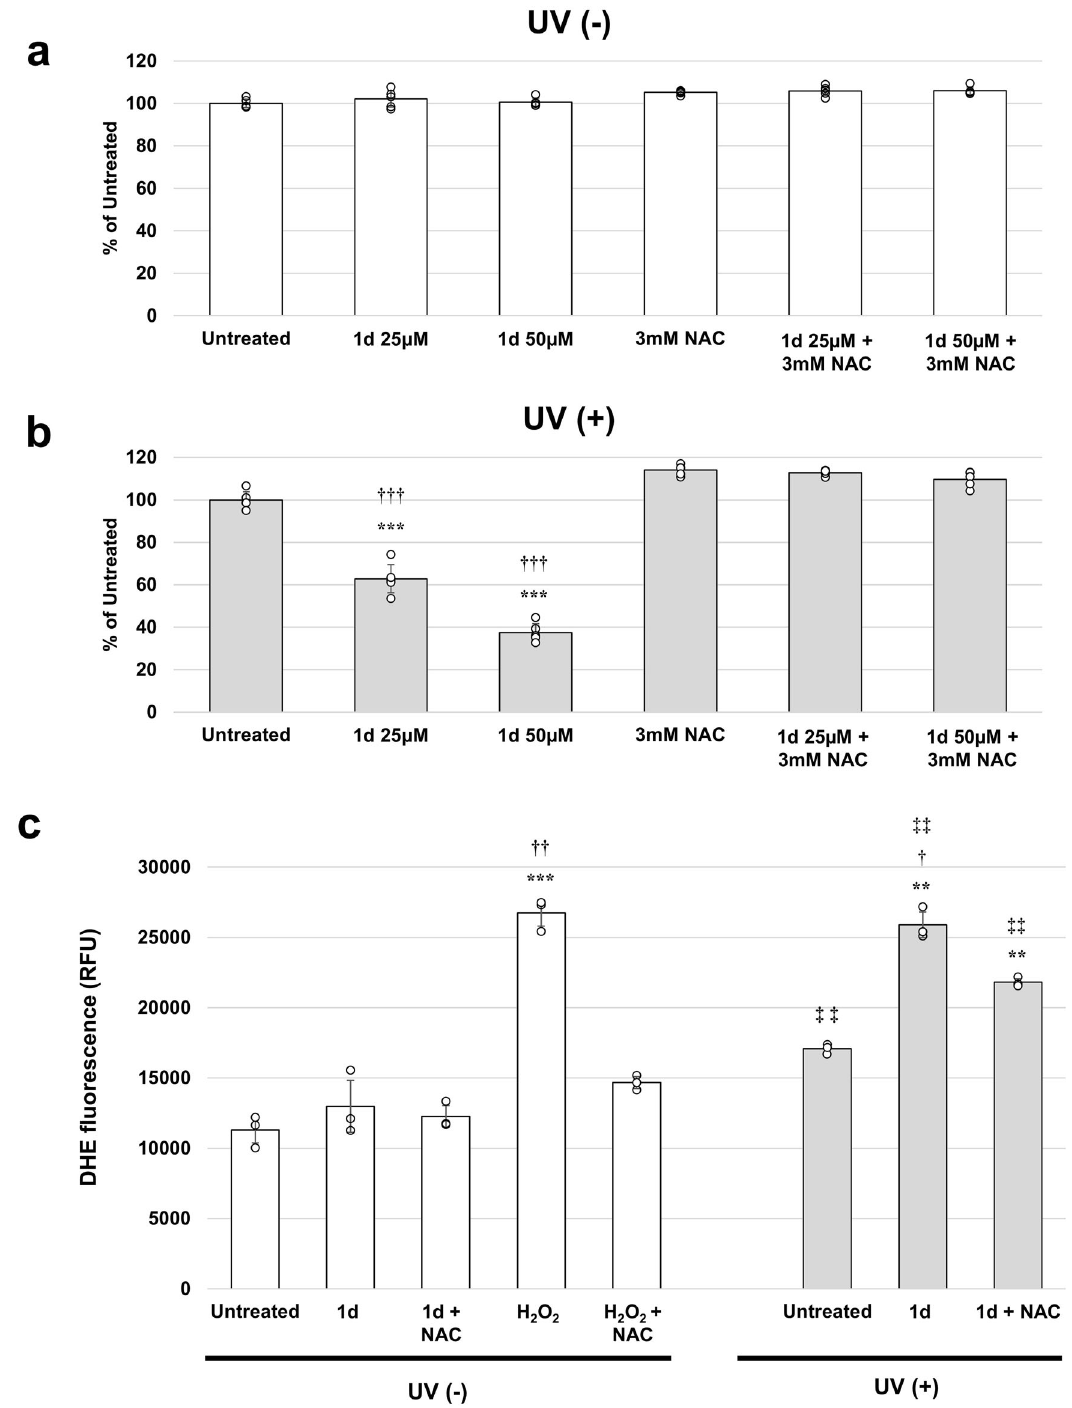
Fig. 6 Production of reactive oxygen species (ROS) in 1d after UV irradiation. a HeLa cells were cultured with 25 μ M or 50 µ M of 1d for 1 h with or without 3 mM N -acetylcysteine (NAC), and then the cells were analyzed by WST8 assay without UV irradiation. b HeLa cells were cultured with 25 μ M or 50 µ M of 1d for 1 h with or without 3 mM N -acetylcysteine (NAC), and then the cells were analyzed by WST8 assay with UV irradiation. c HeLa cells were cultured with 50 µ M of 1d or 500 µ M H 2 O 2 (as a positive control of ROS induction) for 1 h with or without 3 mM NAC, and then ROS in the cells was measured by a DHE probe (ROS Detection Cell-Based Assay Kit; Cayman). While 1d did not generate ROS just by being taken up by cells, UV irradiation generated the same level of ROS as the treatment with H 2 O 2 . ** P <0.01,*** P <0.001 (vs Untreated), † P <0.05, †† P <0.01, ††† P <0.01 (vs with NAC), ‡‡ P <0.01 (vs UV ( − )) (Student ’ s t -test) N = 3 biologically independent samples. The error bars represent the standard deviation of the mean.